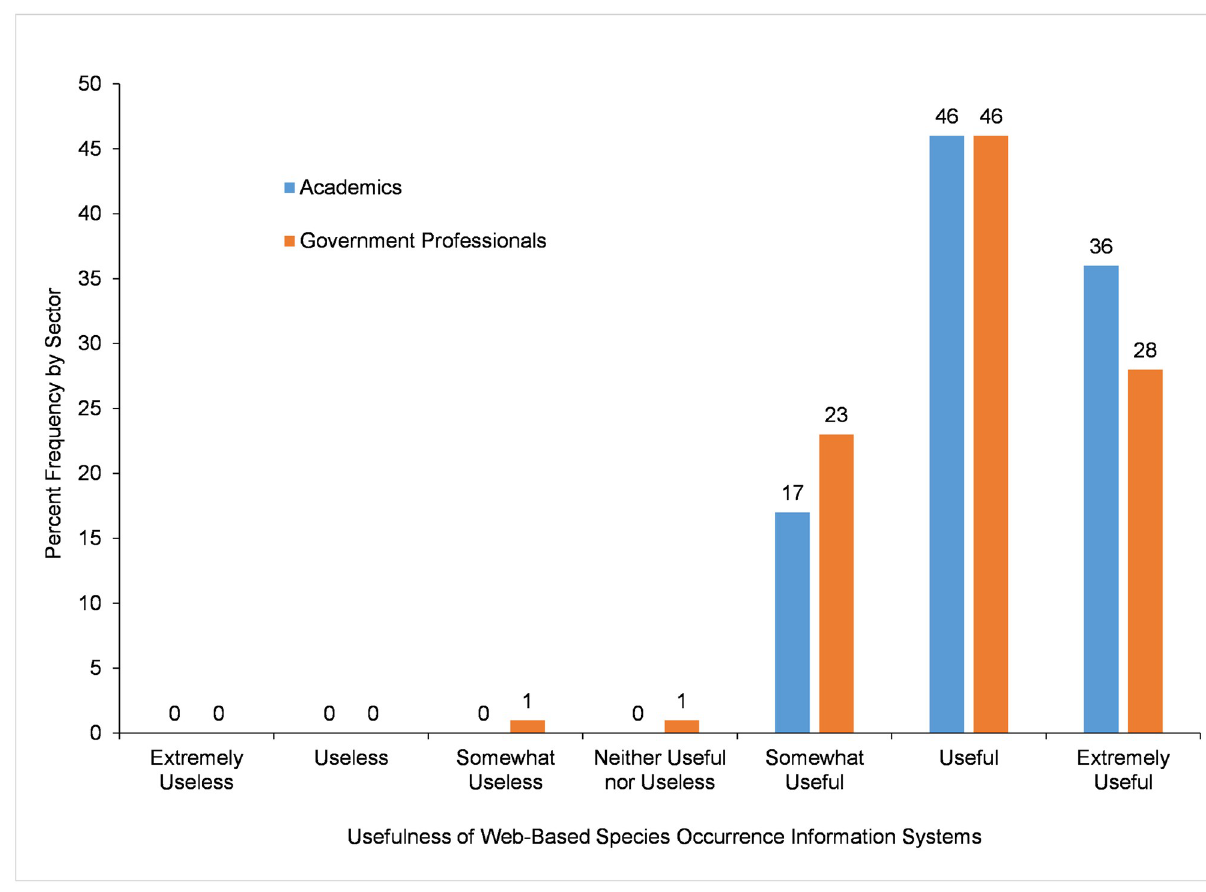
Fig 8. Level of usefulness of web-based species occurrence information